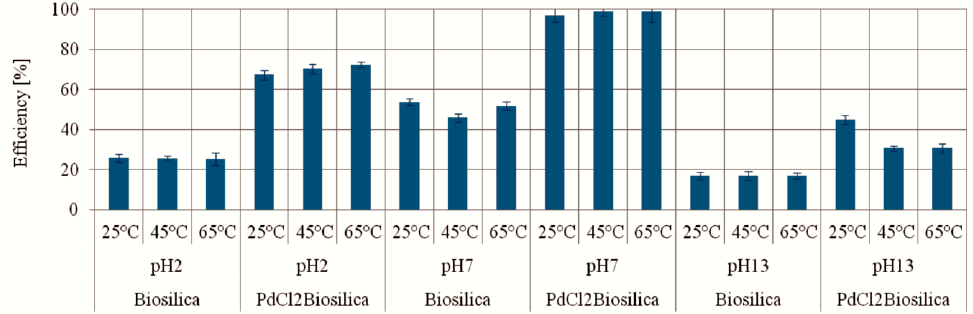
Figure 4. The efficiency of MO photocatalytic degradation for different pH value and temperature. Experimental conditions: t = 90 min; m (Biosilica)—10 mg; C 0 (MO)—9.98 mg/L; V (MO solution)–15 mL.